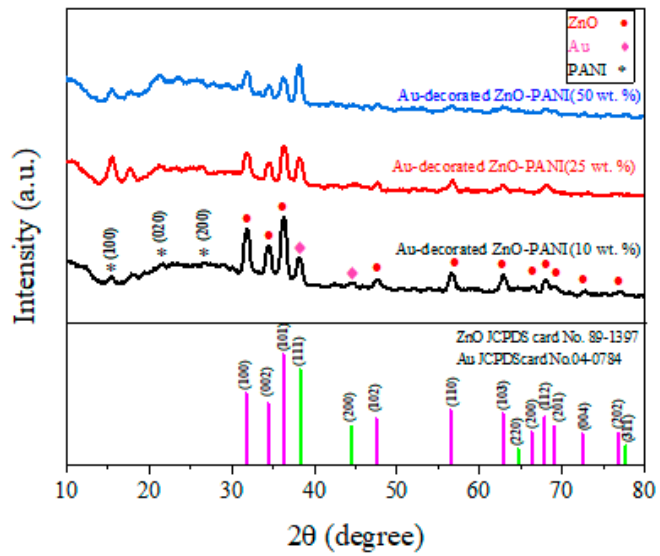
Figure 4. XRD patterns of Au ‐ decorated ZnO ‐ PANI composite nanofibers with different amounts of PANI (10, 25, and 50